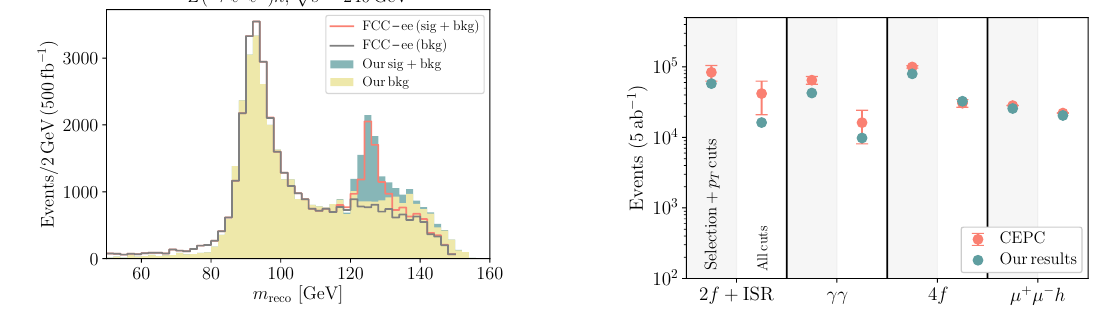
Figure 8 . Left: comparison of our analysis with the TLEP/FCC design study in refs. [5, 15]. Note that p s = 240 GeV in this plot. Right: comparison of our signal and background rates to the CEPC study of ref. [27]. The gray shaded columns labeled ‘Selection + p T cuts’ correspond to requiring at least one (cid:22) + (cid:22) (cid:0) pair with 120 GeV and p T ( (cid:22) + (cid:22) (cid:0) ) > 20 GeV ((cid:12)fth row of table 2 in [27]). The white columns labeled ‘All cuts’